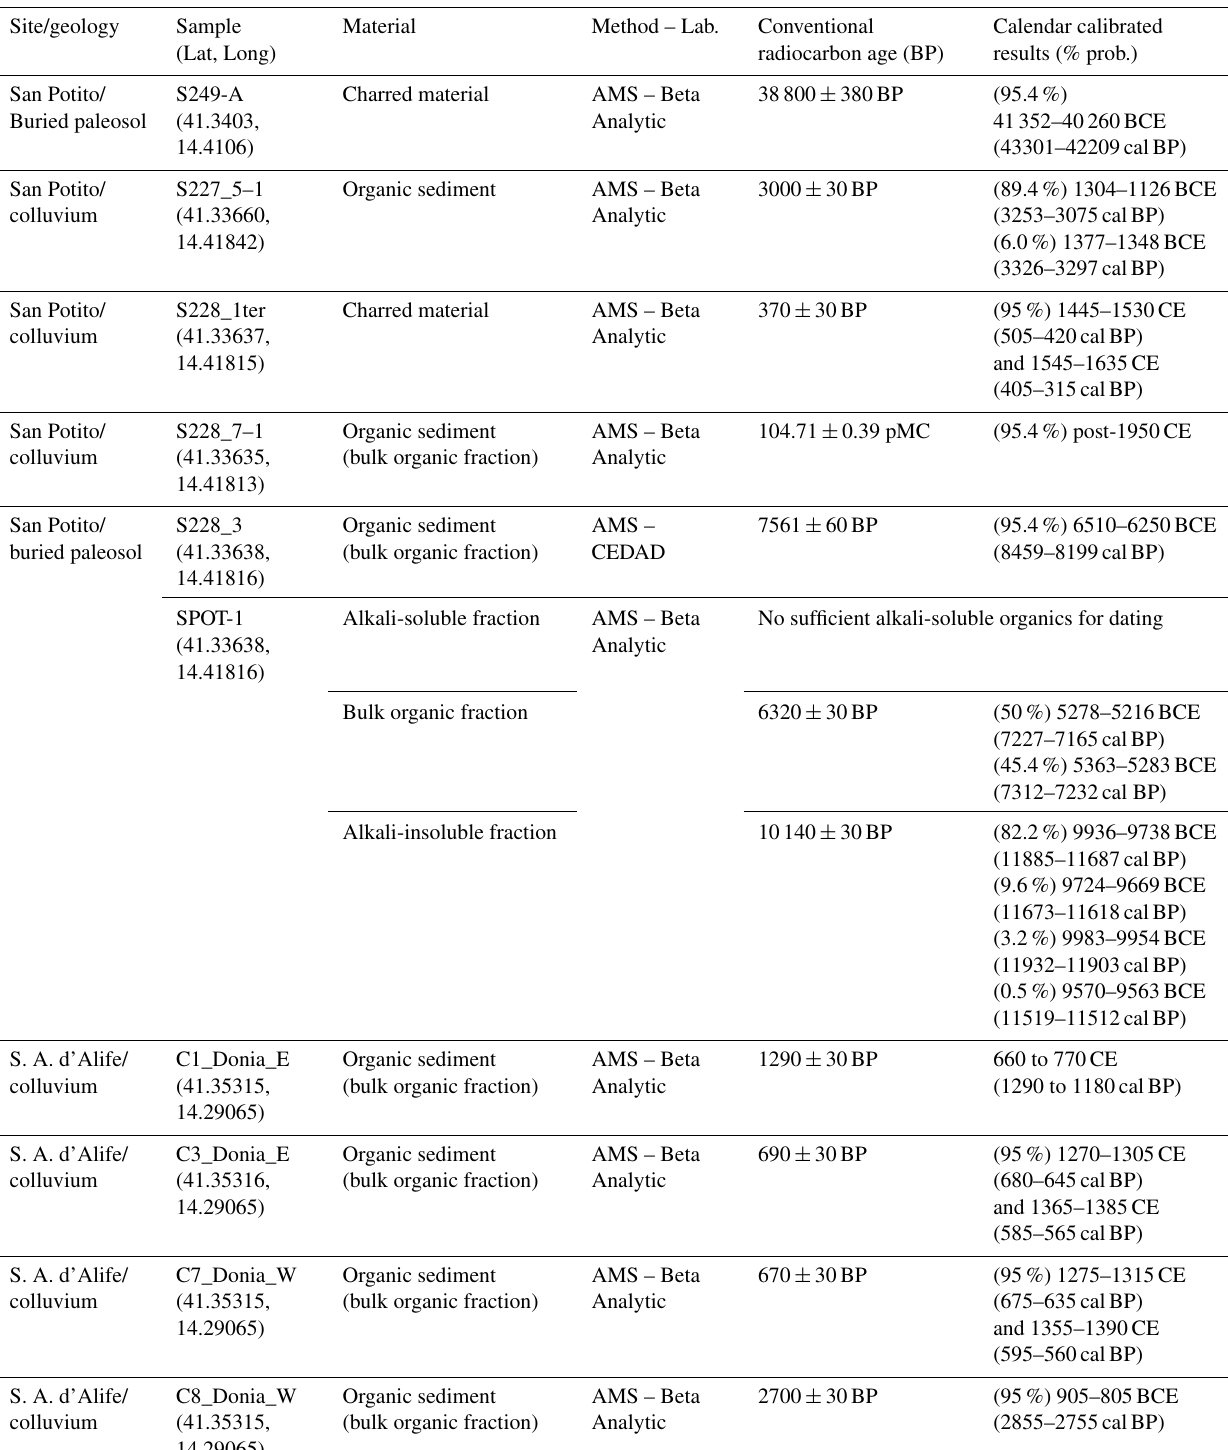
Table 2. Summary of radiocarbon dating